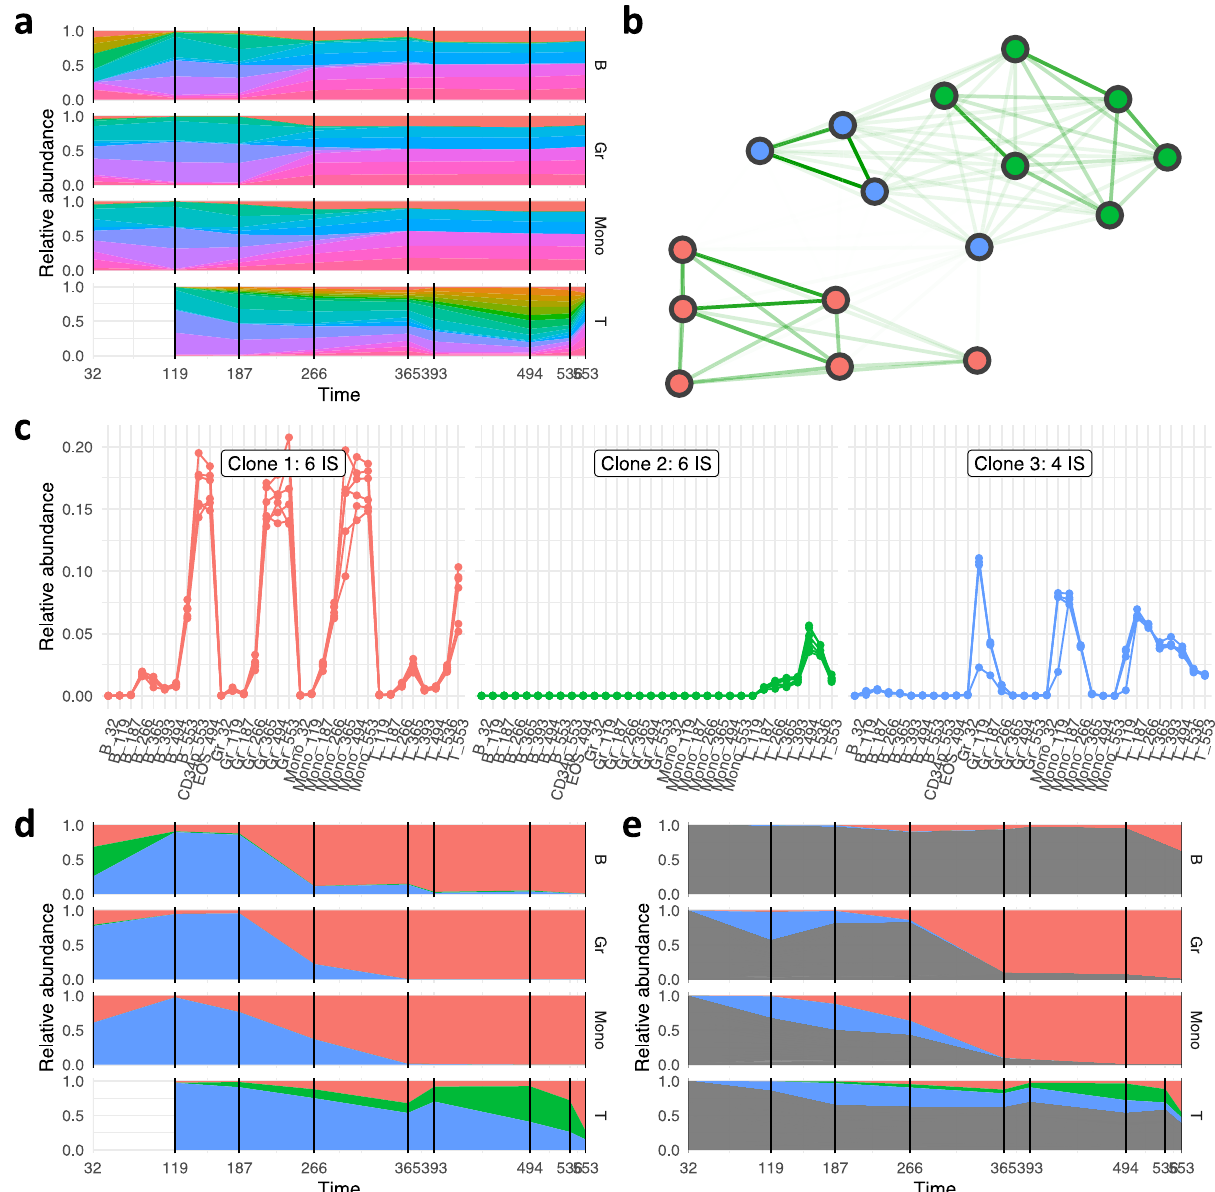
Fig. 7 Experimental data and clonal reconstruction for a rhesus macaque. The animal received an autologous transplant in which the HSPCs were transduced with a lentiviral vector containing a strong constitutive promoter-enhancer. The respective data for IS abundance in different compartments and at different time points is available from ref. 29 . a Relative abundances of IS as a function of time for subsets of cells (T-lymphocytes, B-lymphocytes, granulocytes, monocytes), for which multiple measurements are available. b After fi ltering for all IS with a relative abundance >1% at the fi nal time point (553 d), 16 IS were further analyzed. The network map depicts the similarity between each pair of IS (indicated by edge brightness) superimposed by the optimal clustering obtained from the reconstruction pipeline (indicated by color of the nodes). c Time series of all IS assigned to the same clusters (preserving the color scheme). d Corrected clonal time series for the three identi fi ed clones. e Corrected clonal time series together with the IS that did not pass the initial fi ltering step (indicated in